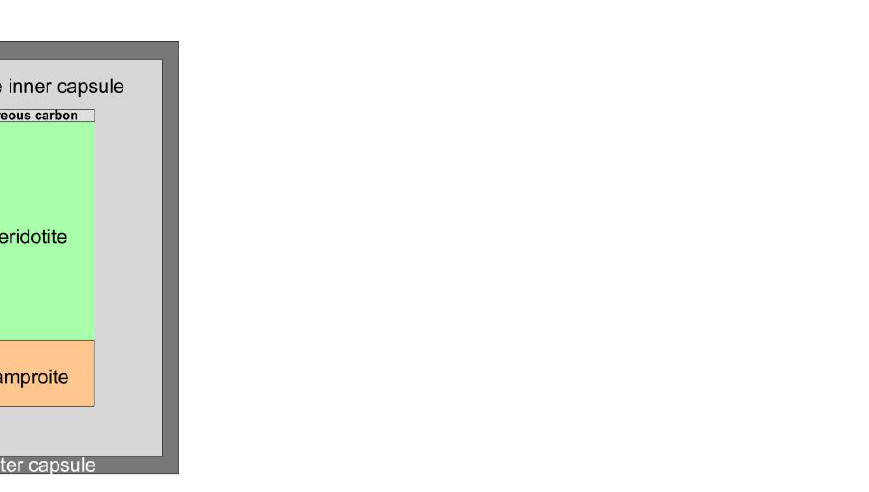
Figure 1. Capsule design for dynamic metasomatism experiments. Lamproite loaded below peridotite as separate layers so that melt must flow against gravity, drawn through by suction of the vitreous carbon melt trap, present at 3.5–4.5% of the volume of the silicate charge. Inner graphite capsule prevents iron loss to outer sealed Pt capsule.